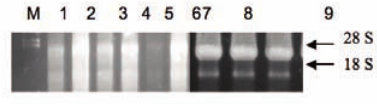
Figure 1. Heat-denatured gel electrophore- sis of total RNA extracted from in vitro A. annu a L. clones using three different methods. M, RiboRuler™ RNA Ladders (Fermentas); 1-3, TC1, TC2 and Highland RNA using IQeasy™ Plus Plant RNA Extraction Mini Kit; 4-6, TC1, TC2 and Highland RNA using cetyltrimethyl- ammonium bromide (CTAB) plus glacial acetic acid; 7-9, TC1, TC2 and Highland RNA using modified CTAB.